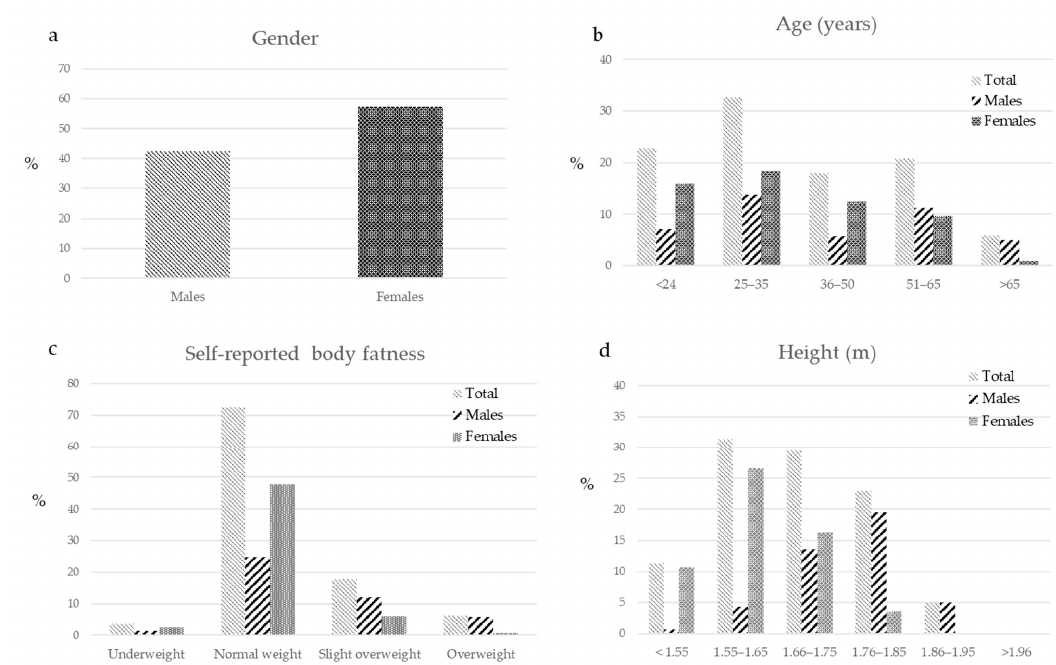
Figure 1. Demographic distribution of the surveyed operators, expressed in percentages. ( a ) A higher percentage of females was found (57%). ( b ) Age of the operators was highly variable and comprises a high percentage of young dental professionals. In particular, over 50% of the participants were younger than 35 years ( c ) Over 70% of the surveyed professionals had normal weight and approximately 20% stated slight overweight. ( d ) The height was uniformly distributed with small groups of very tall and very short operators. Int. J. Environ. Res. Public Health 2021 , 18 , x